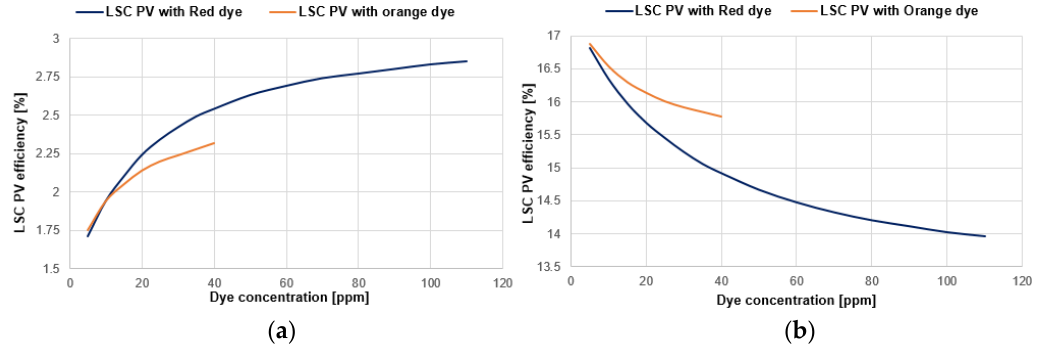
Figure 8. The efficiency of the LSC PV devices as a function of the dye concentration: ( a ) the device with the cells on the edges (case 3); ( b ) the device with the cells on the back and on the edges (case 5). Table 2. The LSC PV efficiency of the optimal cases. Orange Dye Red Dye Full Device Device with Only Side Cells Full Device Device with Only Side Cells